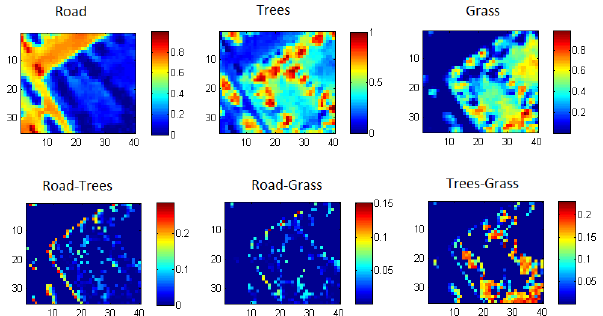
Figure 3. Fraction maps estimated using GBM